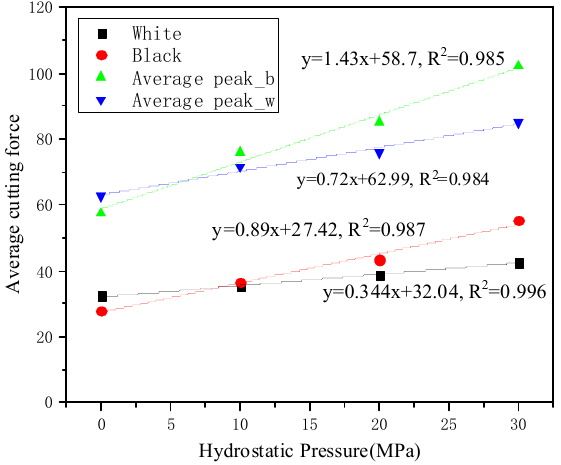
Figure 16. Average cutting force under different ambient pressures.